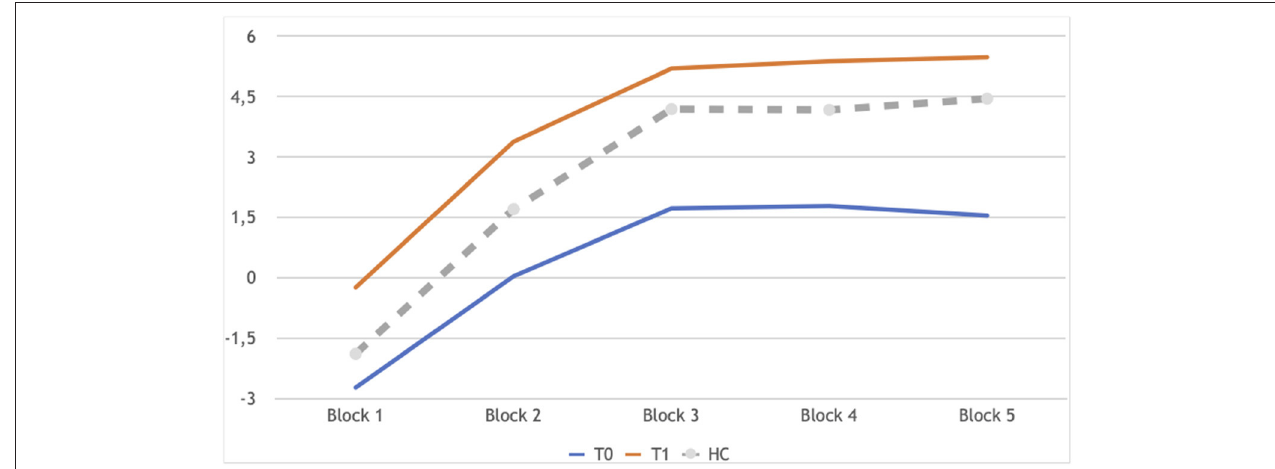
FIGURE 1 | IGT learning profile of patients in longitudinal assessment: T0 and T1 in comparison. Block 1: Z − 2.44, p 0.014; Block 2:Z − 2.73, p 0.006; Block 3: Z − 2.58, p 0.010; Block 4: Z − 2.86, p 0.004; Block 5: Z − 2.68, p 0.007. In gray the performance of controls at T0, as a reference, not included in the analyses reported